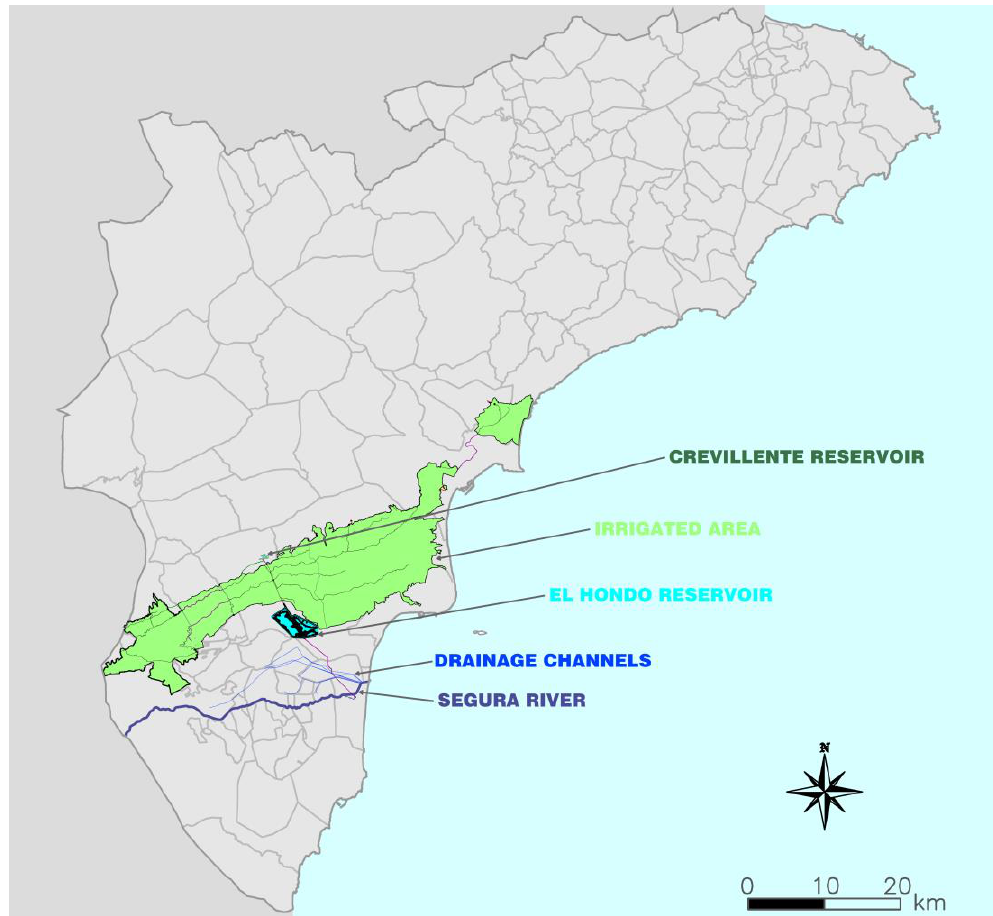
Figure 1. Irrigated area into Alicante province.